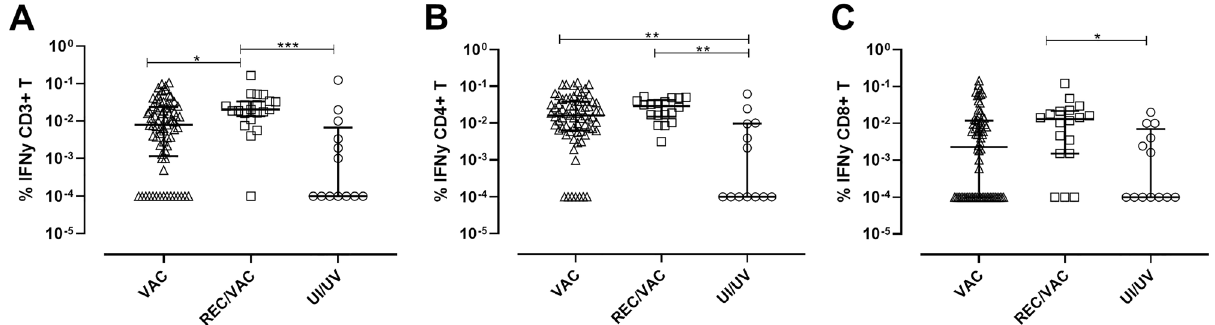
Figure 4. IFN-gamma production by T cells stimulated with SARS-CoV-2 pooled OPPs. PBMCs from vaccinated individuals (VAC) (triangles) (n = 72); COVID-19 recovered vaccinated individuals (REC/ VAC) (squares) (n = 21) and uninfected/unvaccinated donors (UI/UV) (circles) (n = 13) were incubated for 18 h with a mixture of grouped SARS-CoV-2 peptide pools (M + N + S) at a final concentration of 1 μg/mL. The logarithmic scale represents the percentage of T cells producing IFN-γ. Scatter plots show lines at the median with interquartile ranges. IFN-γ expression by total lymphocytes (CD3+ T cells) ( A ); CD4+ T ( B ) and CD8+ T-lymphocytes ( C ) was analysed by intracellular staining. One-way ANOVA and the nonparametric Kruskal–Wallis test were used to compare the study groups. Asterisks denote statistically significant differences between the groups (* p < 0.05; ** p < 0.01; *** p <